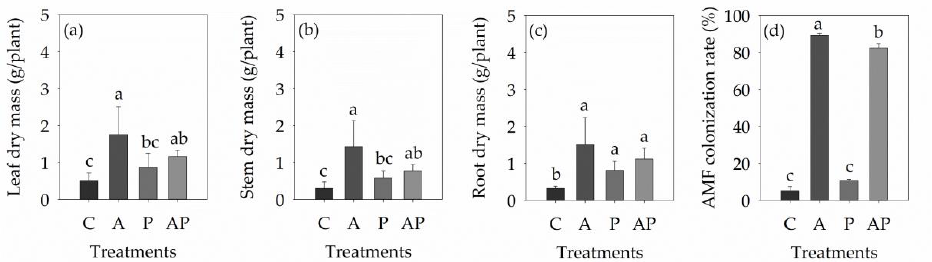
Figure 3. Effects of Glomus mosseae and Bacillus amyloliquefaciens on biomass and arbuscular fungi (AMF) colonization rate of Elaeagnus angustifolia L. seedlings in saline soil. Values are the means ± standard deviation of five replicates. Value sharing the di ff erent letters indicate significant di ff erences between treatments at the 5% level (Tukey’s t-test). C: Control, A: AMF ( Glomus mosseae ) treatment, P: plant growth-promoting rhizobacteria (PGPR) ( Bacillus amyloliquefaciens ) treatment, AP: AMF + PGPR treatment. ( a ) leaf dry mass, ( b ) stem dry mass, ( c ) root dry mass, ( d ) AMF colonization